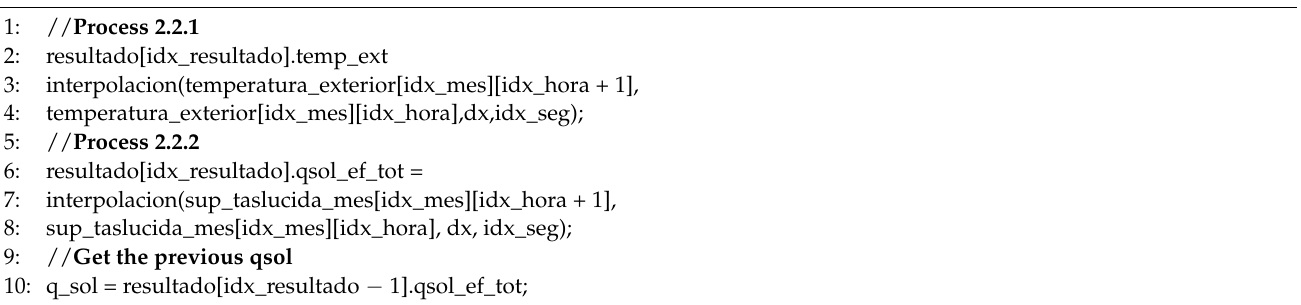
Figure 6. First step of the energy demand calculation process. Algorithm 1 represents the process of obtaining the outside temperature and solar irradiance though the windows over a given period. In both procedures, linear interpo- lation is applied to the analysed variable based on the process in question. Process 2.2.1 corresponds to the outside temperature according to simulation time (hour and month), and process 2.2.2 is applied to solar irradiance through the windows corresponding to the simulation time.